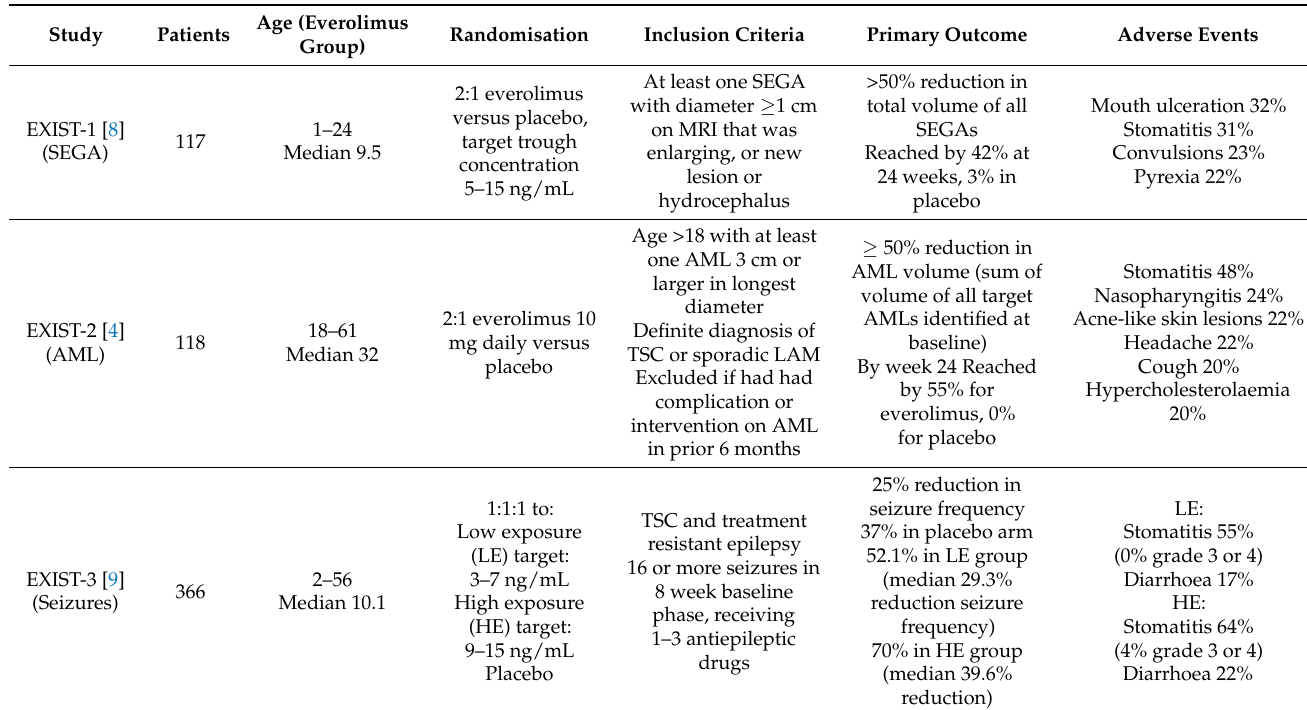
Table 1. Summary of EXIST randomised control trials of everolimus in